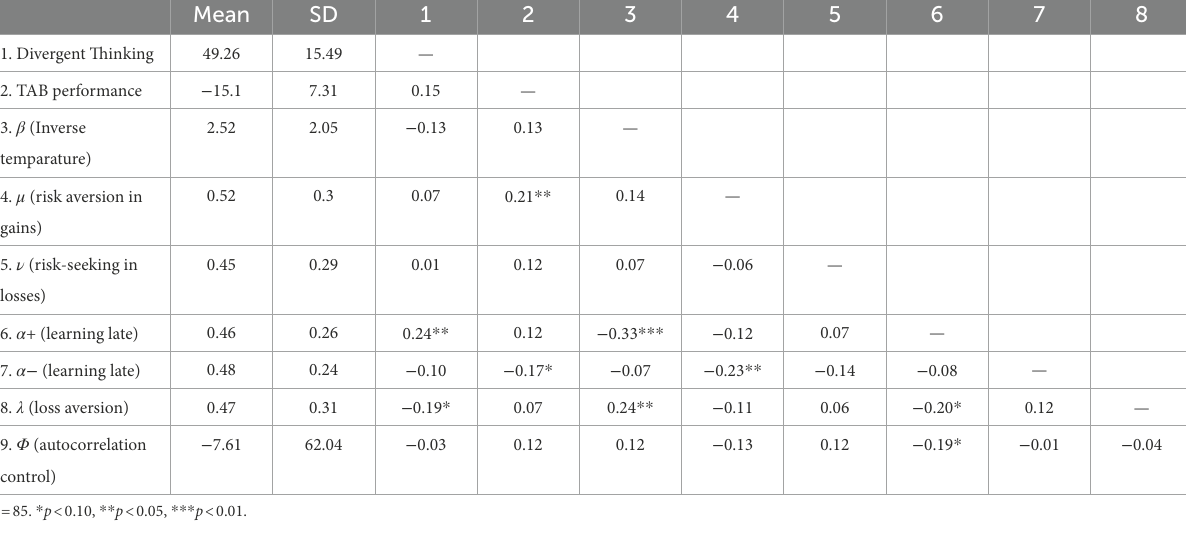
TABLE 1C Descriptive statistics (dyads).